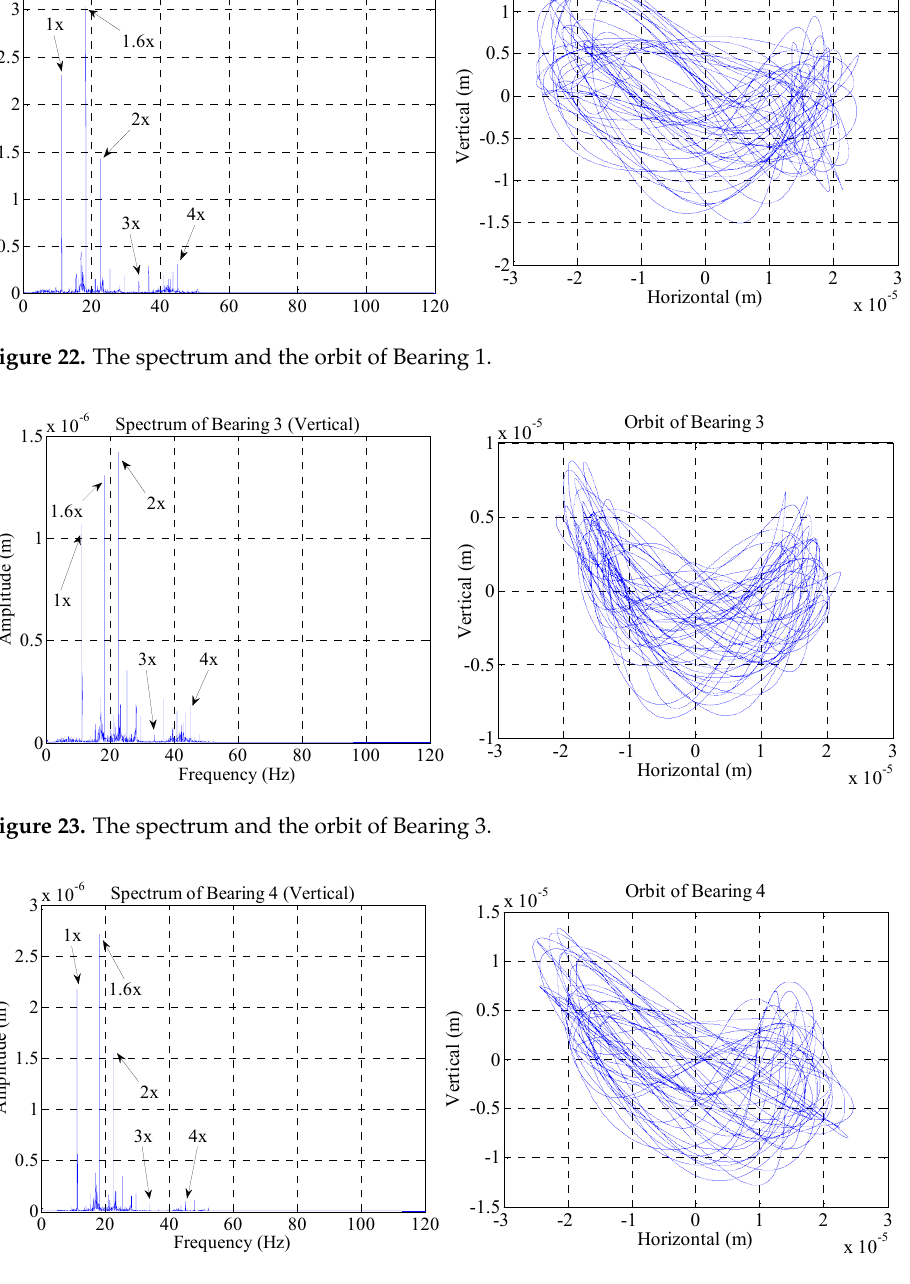
Figure 24. The spectrum and the orbit of Bearing